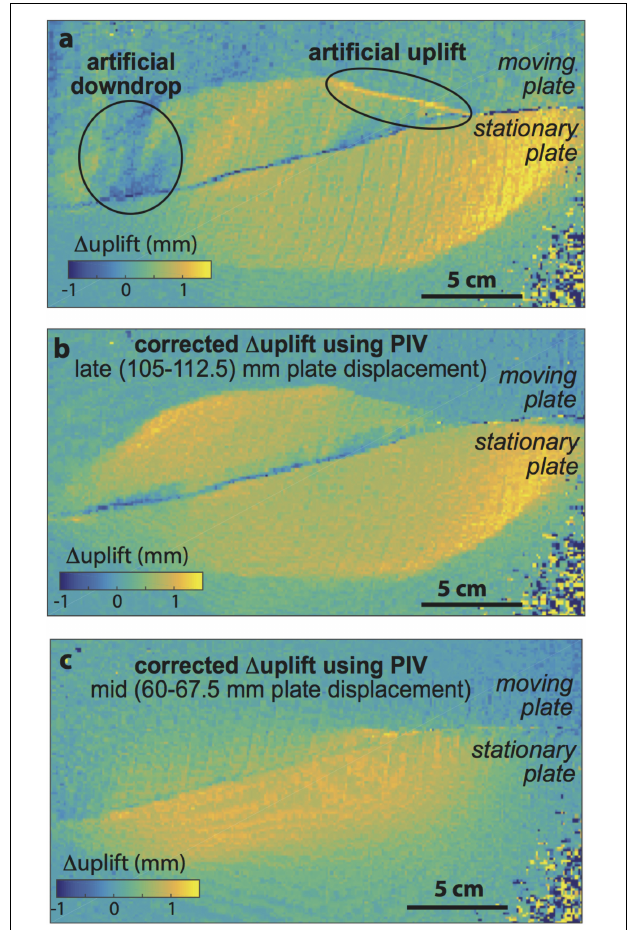
FIGURE 3 | Example incremental uplift maps showing the change in surface elevation over a 7.5 mm increment of applied plate displacement late in the experiment. The lower resolution of the incremental uplift maps compared to the cumulative uplift map reflects the downgrading of the DEM to the resolution of the PIV in order to adjust the horizontal position of migrating structures. (a) The differences between elevation at 112.5 and 110 m of plate displacement without PIV correction. The highlighted regions contain artificial down-drop and uplift due to lateral movement of the clay morphology on the moving plate. (b) The change in elevation for the same interval of plate displacement as A but using the PIV data to correct for the lateral movement. The artificial elevation changes are removed and the resulting change in morphology corresponds to fault activity during this period. (c) Incremental uplift for a 7.5 mm stage near the middle of the